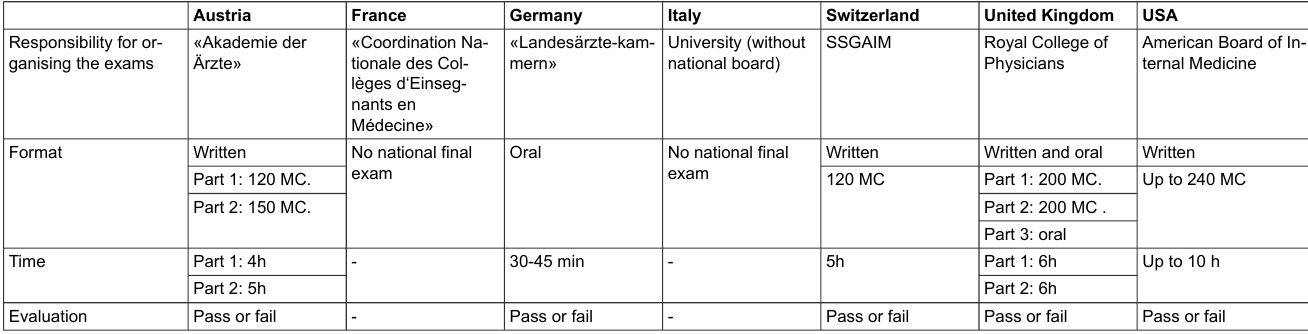
Table 1: Comparison of the board examinations for general internal medicine in different